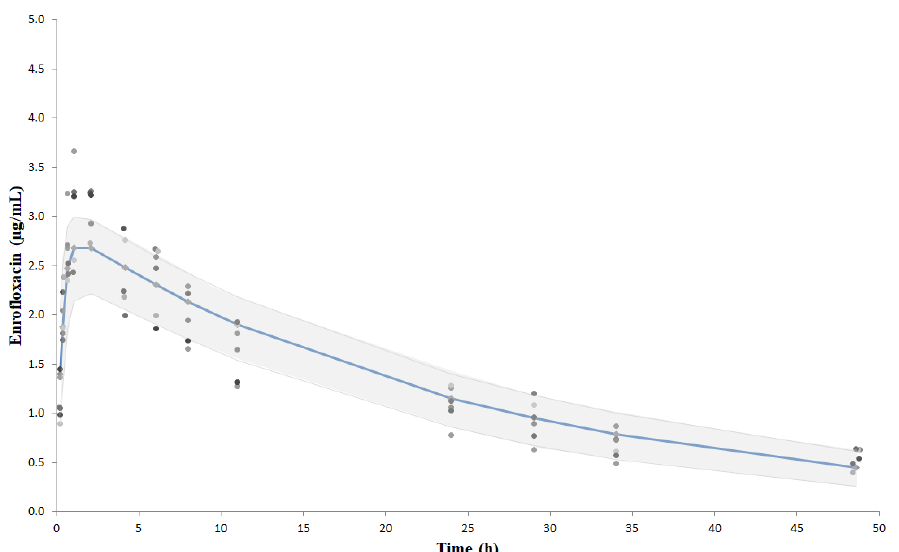
Figure 1. Plasma concentrations vs time profiles of enrofloxacin after a single intramuscular dose of 10 mg/kg in Coragyps atratus ( n = 6). Solid lines show the final model fits. Shaded grey represents the confidence intervals of 95% of the predictive check for model evaluation after Monte Carlo simulation. Observed values of each bird are shown in greyscale. Table 1. Pharmacokinetic parameters obtained after enrofloxacin intramuscular administration (10 mg/kg) in black vul- tures ( Coragyps atratus ) ( n = 6) . Pharmacokinetic Parameter